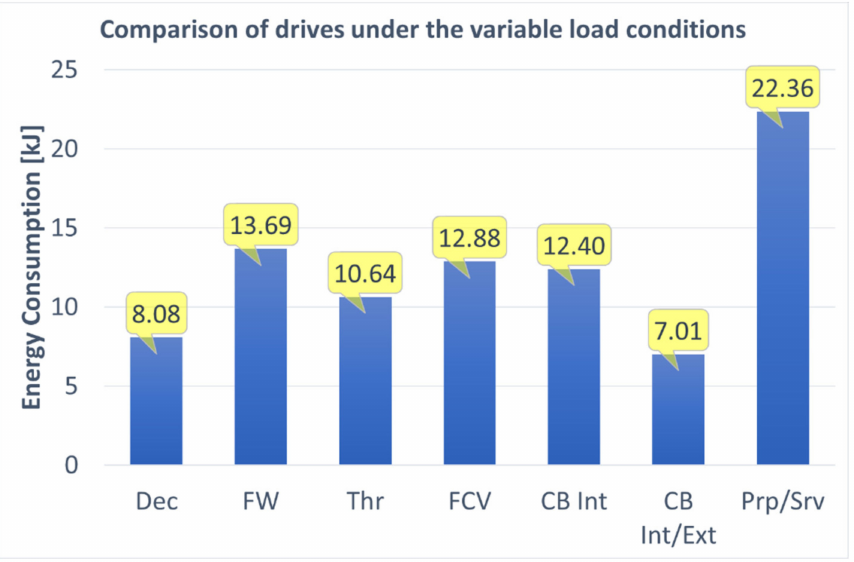
Figure 20. Energy consumption of different drives with double-acting actuator under the vari- able